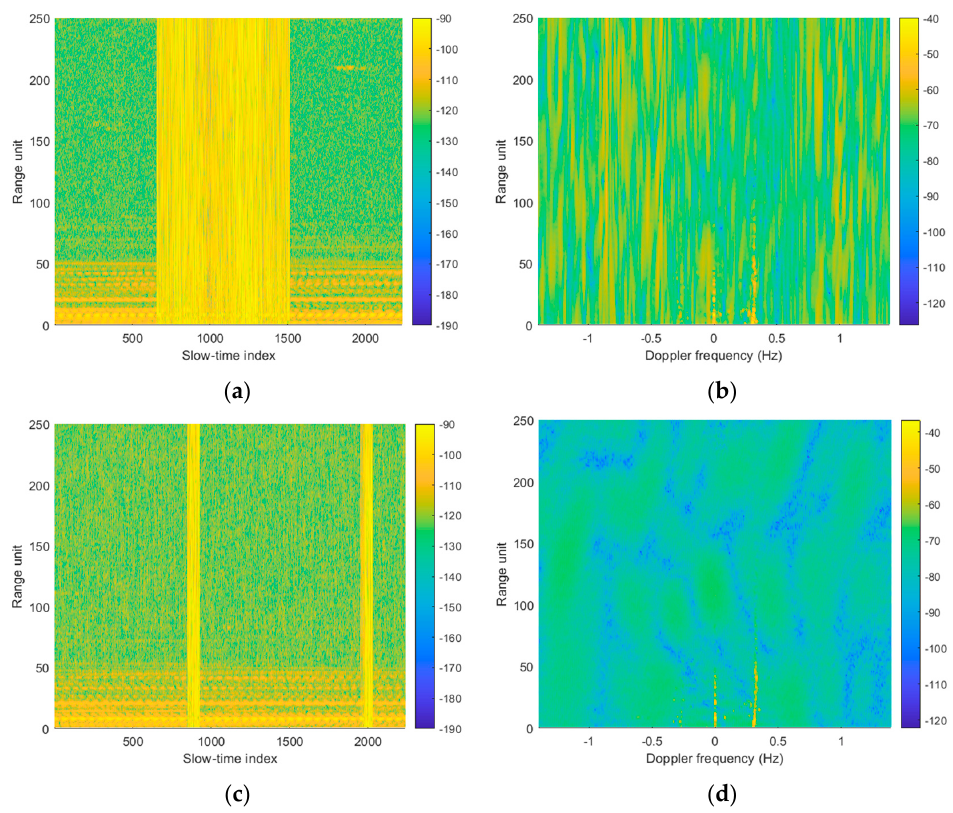
Figure 1. Measured compact HFSWR data contaminated by transient interference: ( a ) the range − STD spectrum of LCI; ( b ) the range − Doppler spectrum of LCI; ( c ) the range − STD spectrum of STI; ( d ) the range–Doppler spectrum of STI.